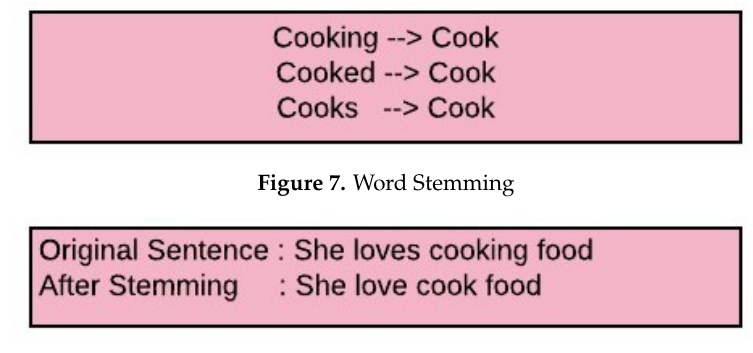
Figure 8. Sentence